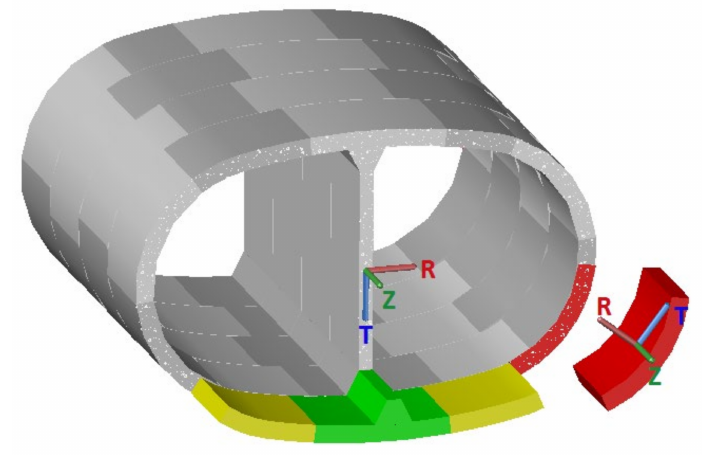
Figure 4. Coordinate of the segments.